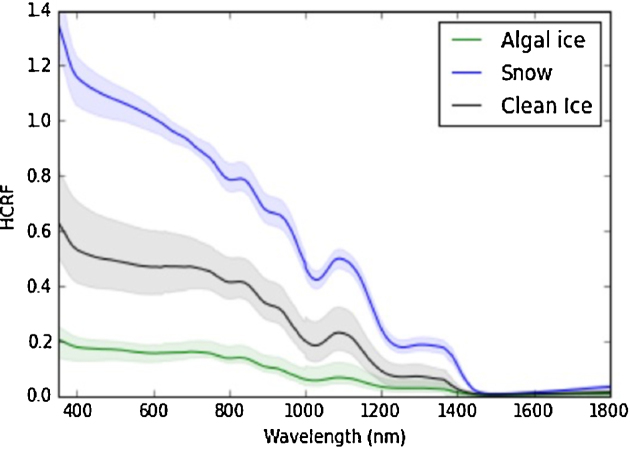
Spectra obtained during transect 1 illustrating the contrasting spectral reflectance of snow (site S1a), clean ice (0 algal cells ml−1, Site S3) and algal ice (0.76 ± 0.19 × 104 algal cells ml−1, Site S3). HCRF = hemispherical conical reflectance factor, obtained by measuring light reflected from the surface relative to a Spectralon white reference panel. Reference panels can be less reflective than fine grained snow at nadir, explaining reflectance values >100%. Data are presented as a proxy for albedo, though correction for the viewing angle and surface anisotrophy are required to calculate albedo from these data (see Cook et al. 2017).